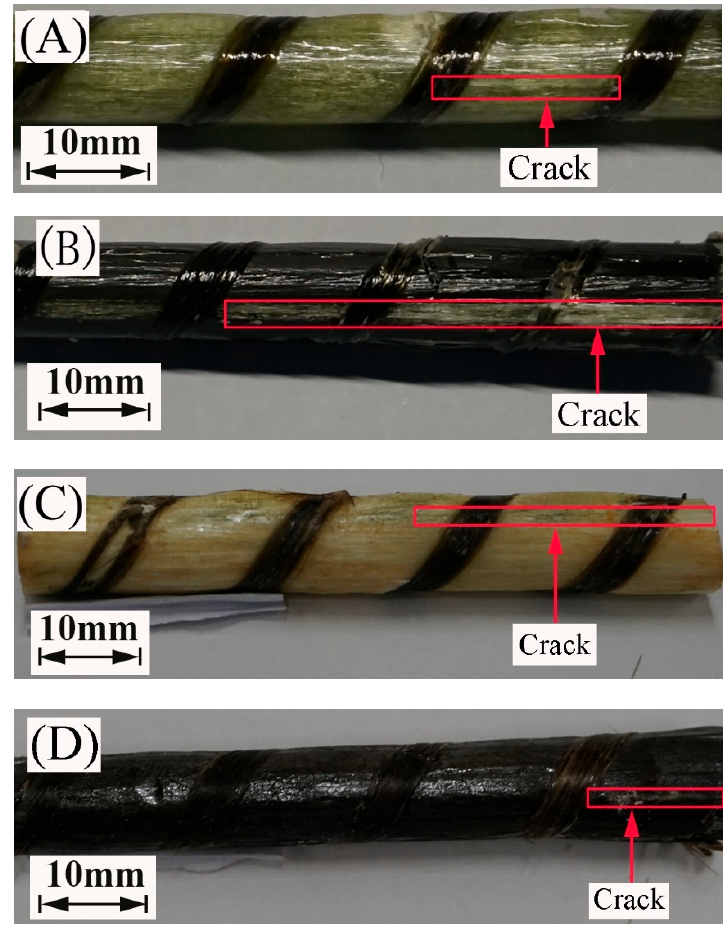
Figure 12. The failure mode of the specimens at a temperature of 60 °C: ( A ) the GFRP bars in water, ( B ) the HFRP bars in water, ( C ) the GFRP bars in the alkaline solution, and ( D ) the HFRP bars in the alkaline solution.